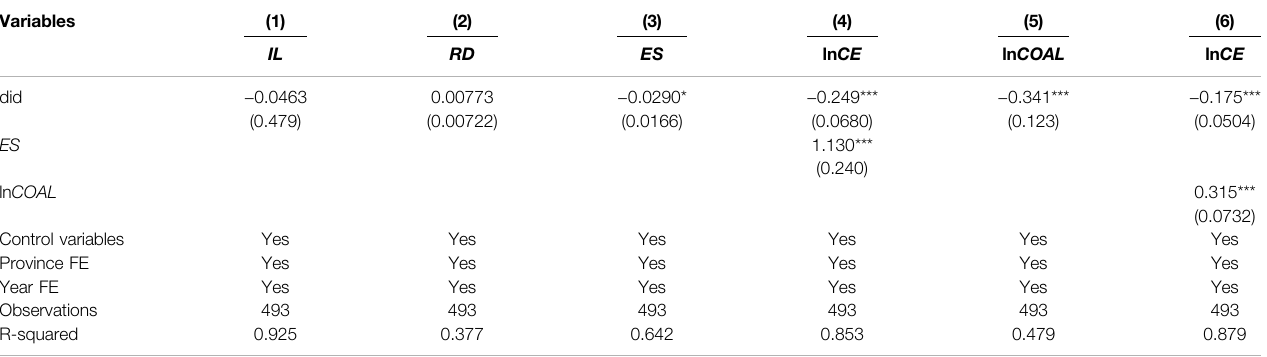
TABLE 4 | Impact mechanism analysis.